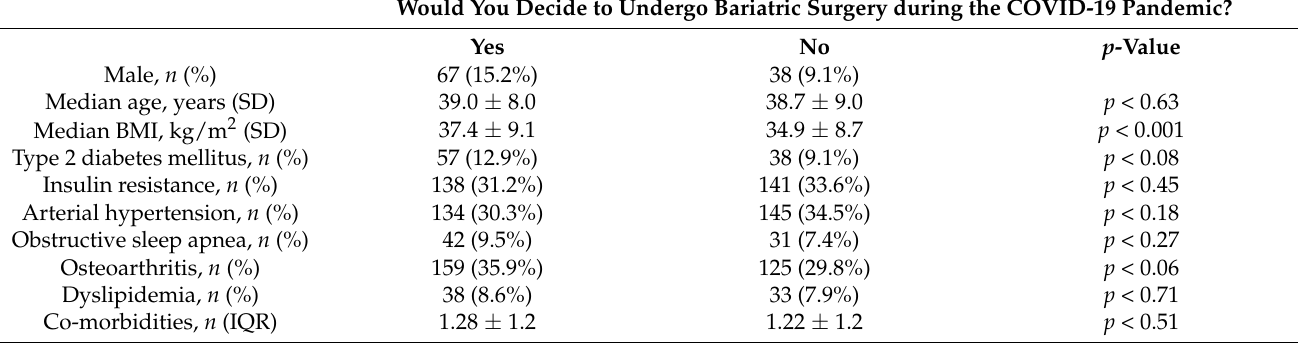
Table 2. Decision about bariatric surgery during the COVID-19 pandemic—all patients. Would You Decide to Undergo Bariatric Surgery during the COVID-19 Pandemic?